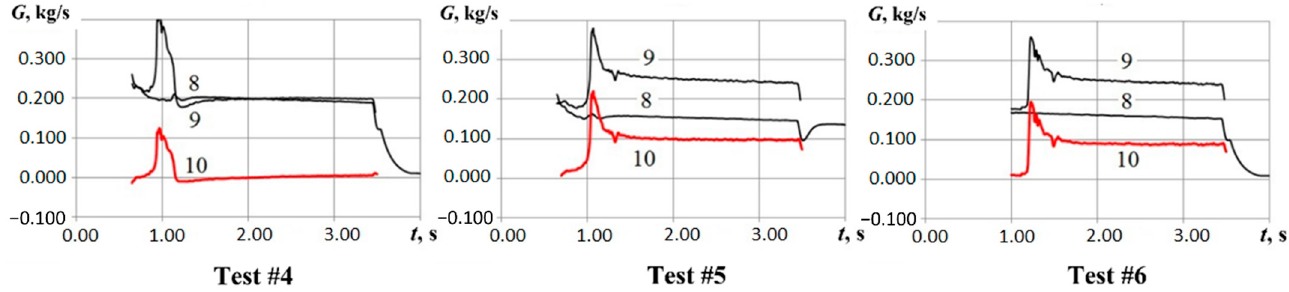
Figure 11. Calculated time histories of flow rates G in (curve 8), G out (9) and Δ G = G out ( t ) − G in ( t ) (10) at М 1 = 3.81 in tests 7 to 9. As mentioned above, LSM combustion in tests 1, 4, and 7 was absent. Therefore, the flow rates G in and G out were virtually equal. In test fires with combustion, a noticeable LSM gasification accompanied with sample combustion was detected. In these latter test fires, the gas flow rates G in and G out differed markedly. According to Figures 9–11 the flow rate of gasification products ( Δ G = G out ( t ) − G in ( t )) in test fires with combustion could be con- stant, like in Figures 9 and 10, or variable in time, like in Figure 11. The mean values of the flow rates of gasification products in Figures 9–11 took the values of 0.08 kg/s at M 1 = 2.43, 0.10 kg/s at M 1 = 2.94, and 0.05–0.02 kg/s at M 1 = 3.81. An important element of test data processing procedure was the determination of LSM sample mass before ( W 1 ) and after ( W 2 ) test fire. The difference between these masses ( Δ W = W 1 − W 2 ) determines the amount of gasified sample material leaving the GG with exhaust gases. Based on the calculated flow rates G in and G out and measured sample masses W 1 and W 2 , one can derive the following balance equation for determining the intake contraction ratio φ :